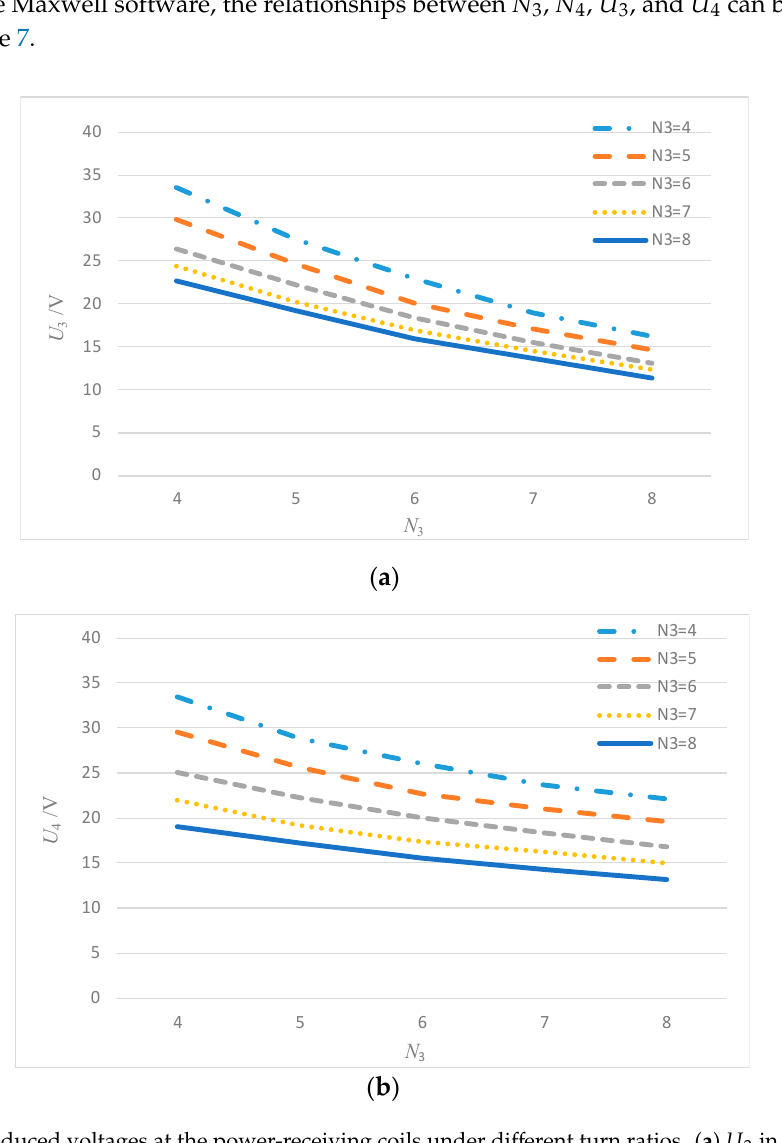
Figure 7. Induced voltages at the power-receiving coils under different turn ratios. ( a ) U 3 in the coil L 3 . ( b ) U 4 in the coil L 4 .